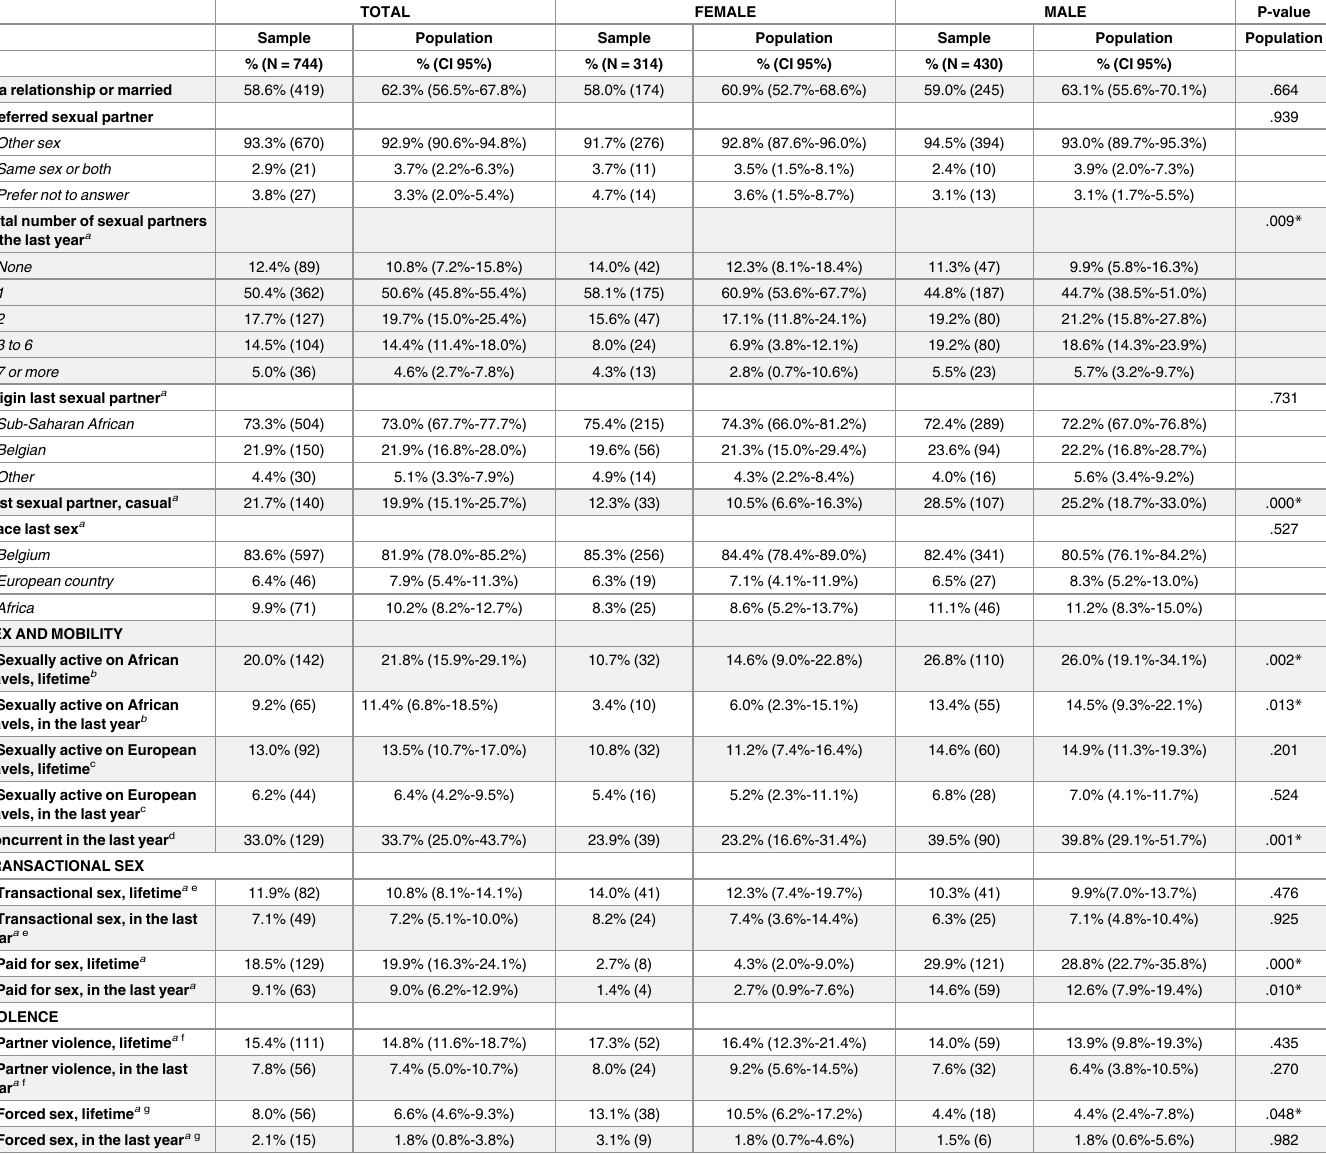
Table 3. Sexual behavior of the sample (unweighted) and population estimates of sub-Saharan African migrants socializing in Antwerp city (weighted), stratified by gender. TOTAL FEMALE MALE P-value Sample Population Sample Population Sample Population